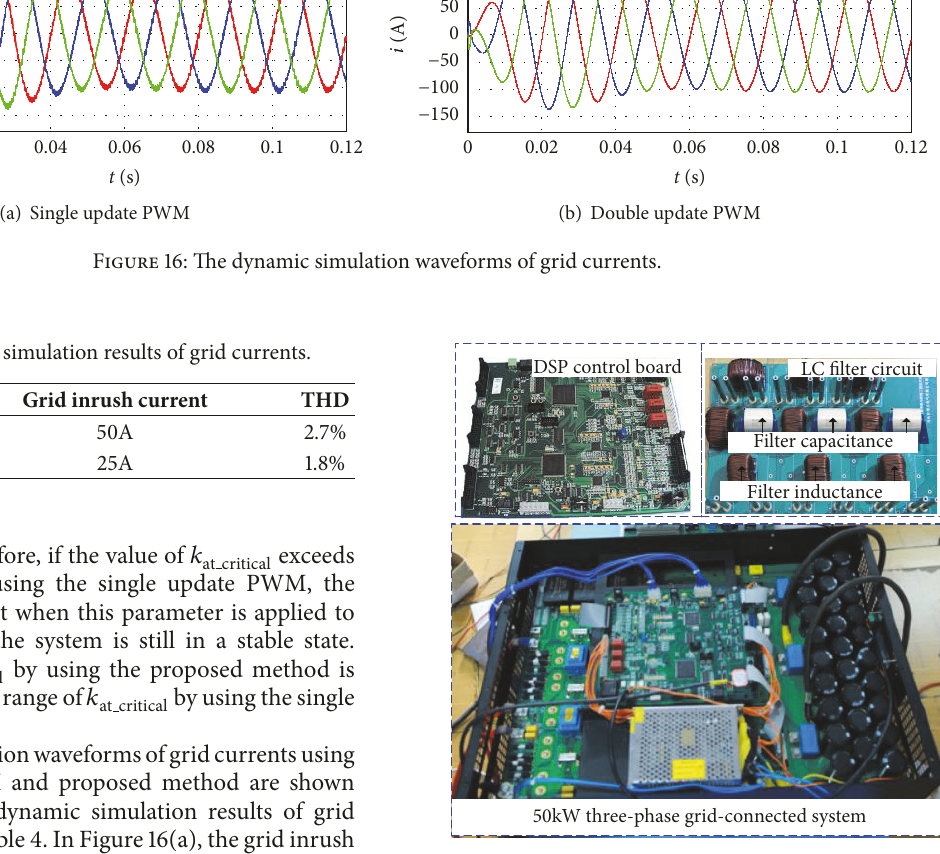
Figure 17: Experimental platform of three-phase grid-connected